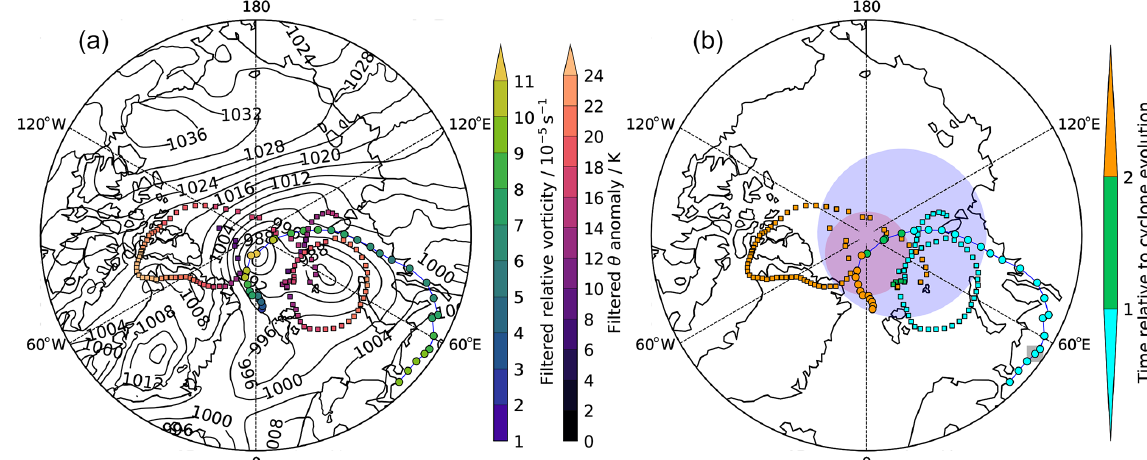
Figure 1. Example of a matched cyclone and TPV with circle markers linked by lines and (unlinked) square markers, respectively, showing the tracks of the cyclone and TPV at 3-hourly intervals: (a) intensity of tracks with MSLP at the time of maximum intensity of the cyclone (15:00UTC on 30 August, defined by filtered ξ 850 ) in black contours (4hPa interval) and (b) timing of tracks (green fill indicates times from that of the maximum growth rate (labelled as “1” on the colour bar) to that of maximum intensity (labelled “2”) inclusive, and blue fill and orange fill indicate times prior to that of the maximum growth rate and after that of maximum intensity, respectively) with the blue transparent circle indicating a 10 ◦ radius around the cyclone at the time of its maximum growth rate, the red transparent circle indicating a 5 ◦ radius around the cyclone at the time of its maximum intensity and the black transparent square indicating the location of the cyclone 2d prior to the time of its maximum growth